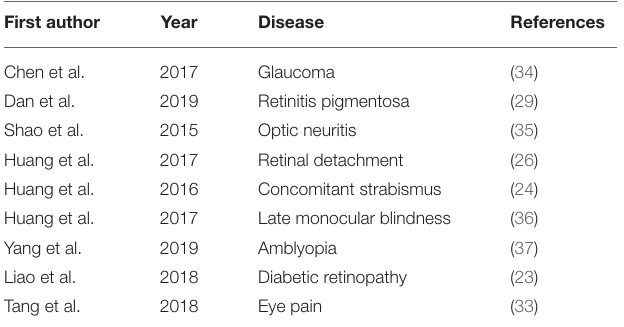
TABLE 4 | Regional homogeneity method applied in ophthalmological diseases.